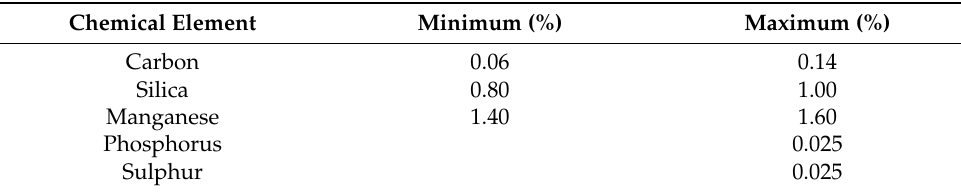
Table 2. Chemical composition of the AWS 5.18 ER 70S-6 electrode.